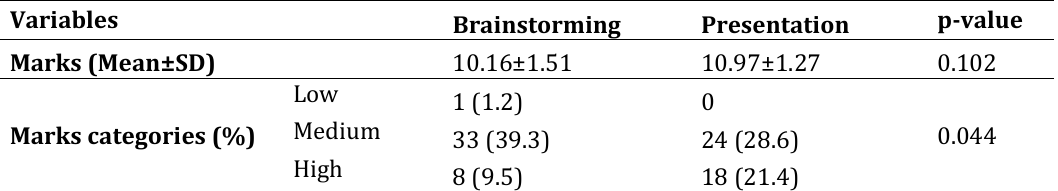
Marks comparison between presentation and brainstorming teaching learning methods Variables